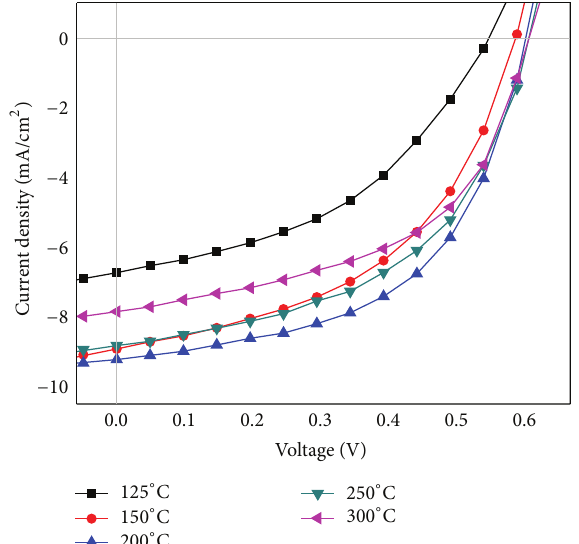
Figure 6: J - V characteristics of devices with ZnO ETLs prepared at different substrate temperatures.